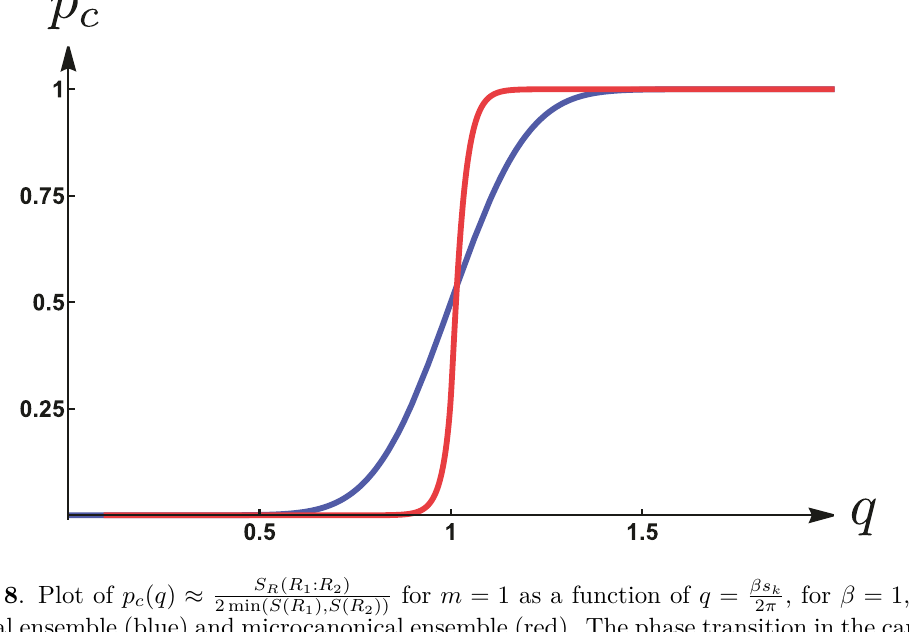
Figure 8 . Plot of p c ( q ) ≈ S R ( R 1 : R 2 ) canonical ensemble (blue) and microcanonical ensemble (red). The phase transition in the canonical ensemble is spread out over a region of size ∆ s = O